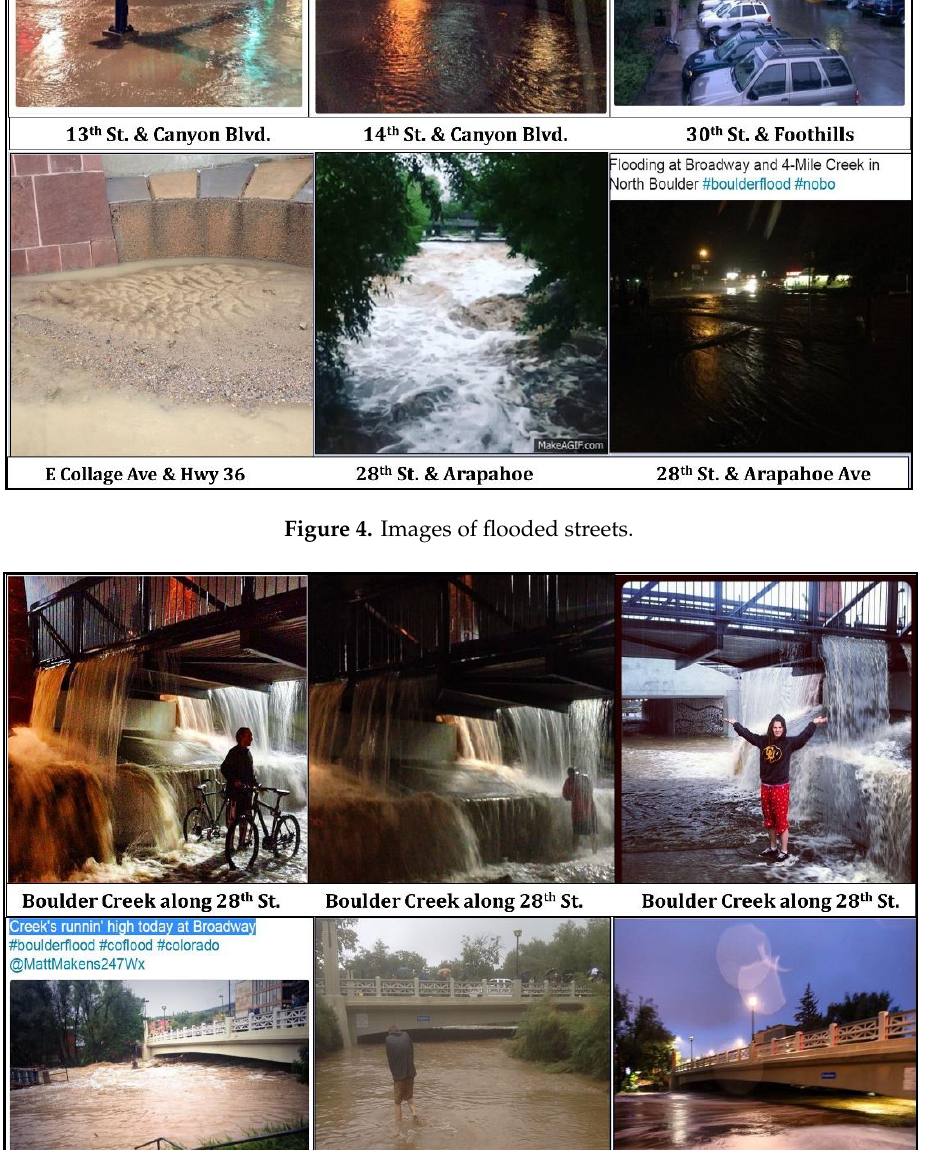
Figure 4. Images of flooded streets.